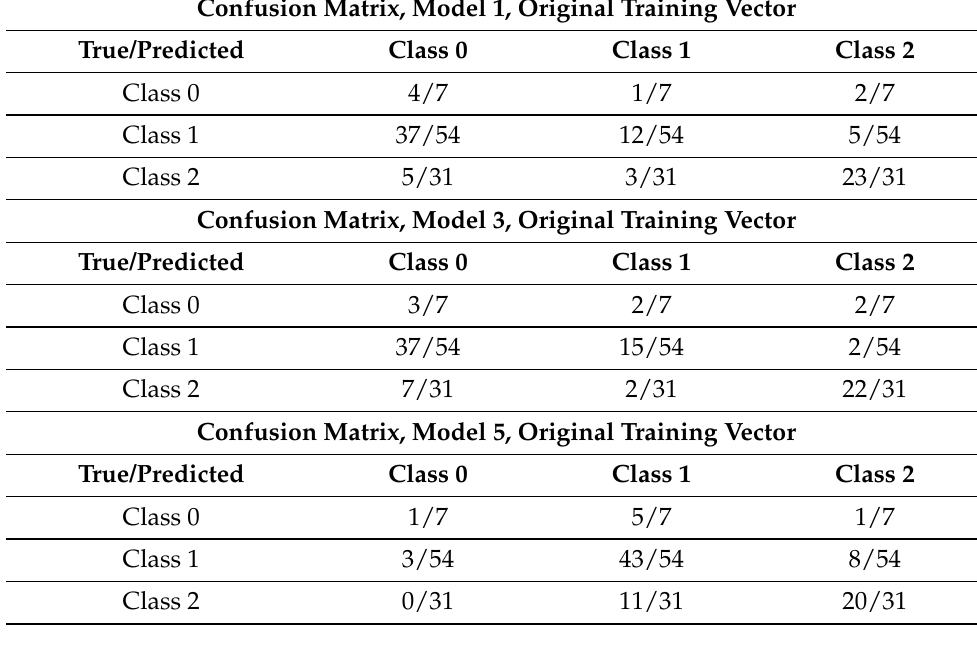
Table 22. Confusion matrices for models 1, 3, and 5, corrected with the original training vector on the validation